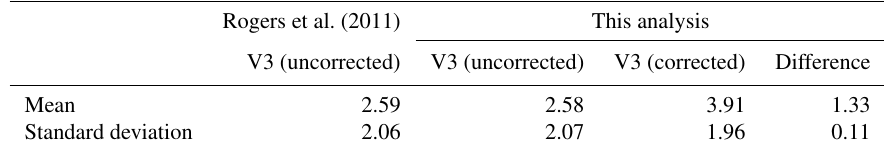
Table A1. The HSRL–CALIOP biases as calculated by Rogers et al. (2011) and after correction of a coding